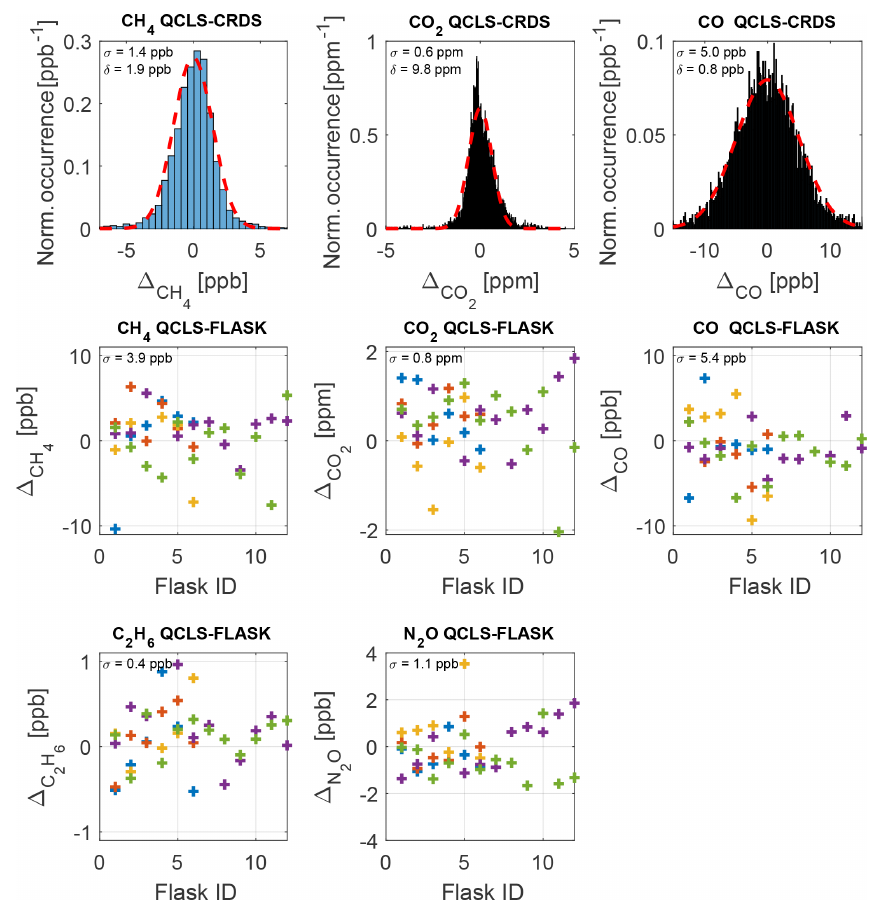
Figure 13. Comparison of QCLS derived mole fractions to well-established in-flight cavity ring-down data and flask samples after correcting for a bias ( δ ) constant for the whole measurement series including standard deviations σ . Interpretation of the errors against flask samples is difficult for high-variability flight segments, due to the large flask sampling time. The residual plots show color-coded data from five typical flights on 3 October 2017 (blue), 11 October 2017 (red), 14 October 2017 (yellow), 18 October 2017 (violet) and 20 October 2017